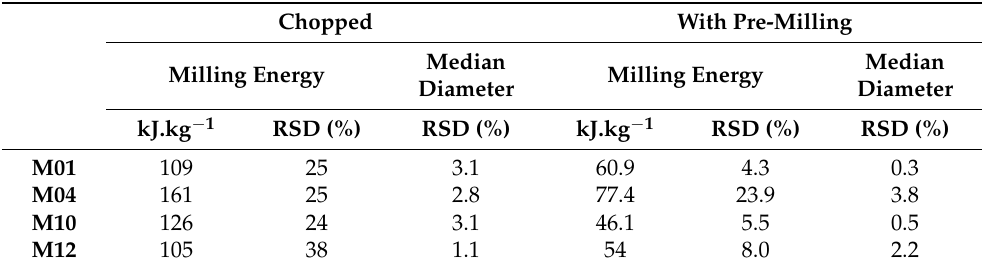
Table 1. Comparison of the repeatability of milling energy measured on chopped samples and on pre-milled samples for four maize inbred lines of maize (M01, M04, M10 and M12) and the particle size obtained after milling (median